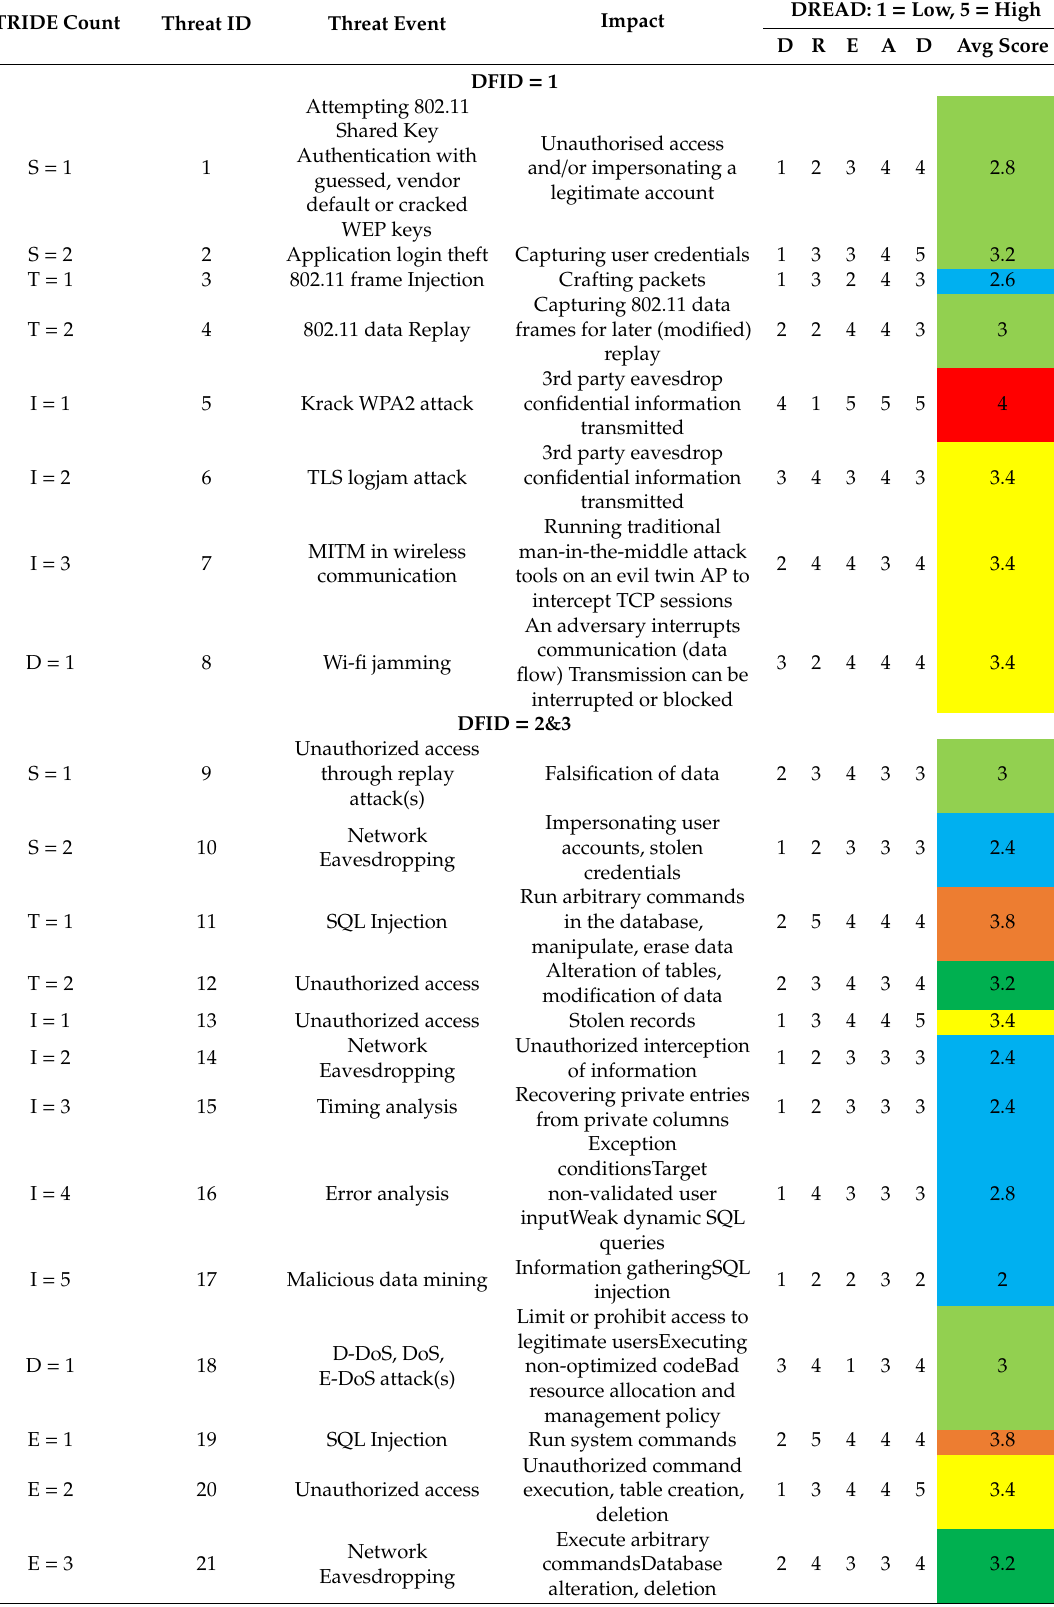
Table 3. Generation of DREAD values for threats of Database access in